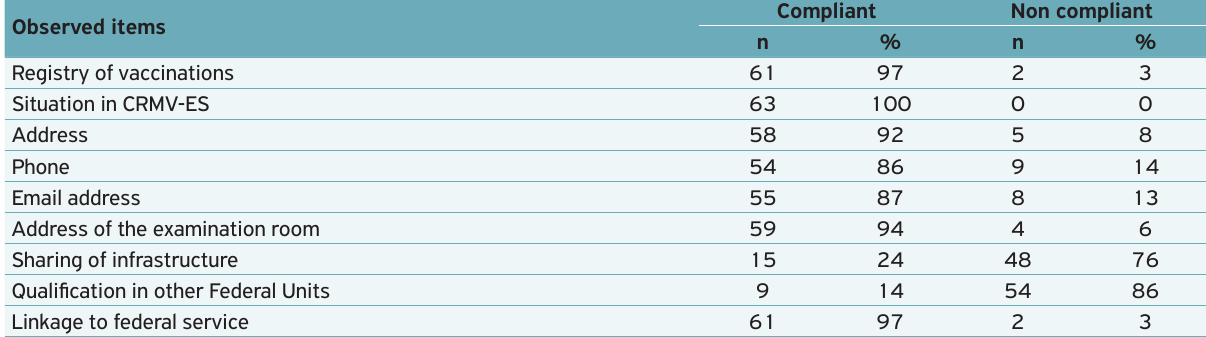
Table 1. Identification of veterinarians qualified to serve on the National Programme for Control and Eradication of Animal Brucellosis and Tuberculosis in forms of supervision conducted by the Institute of Agricultural and Forestry Defense of Espírito Santo state, Brazil, between 2008 and